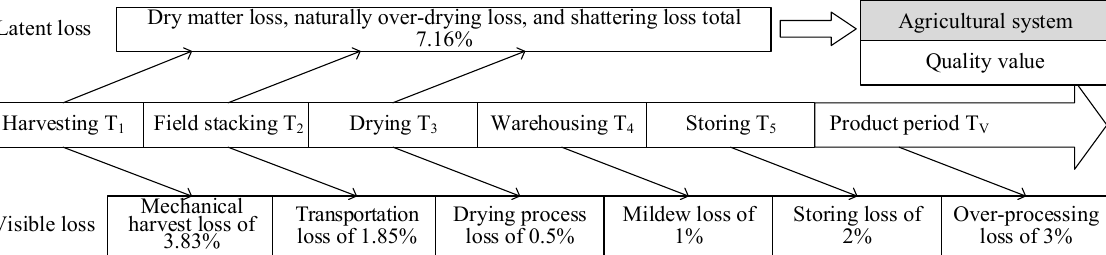
Figure 16. Visible and latent loss of current operation method. Table 2. Latent loss rate of six rice varieties on different days after heading [76].